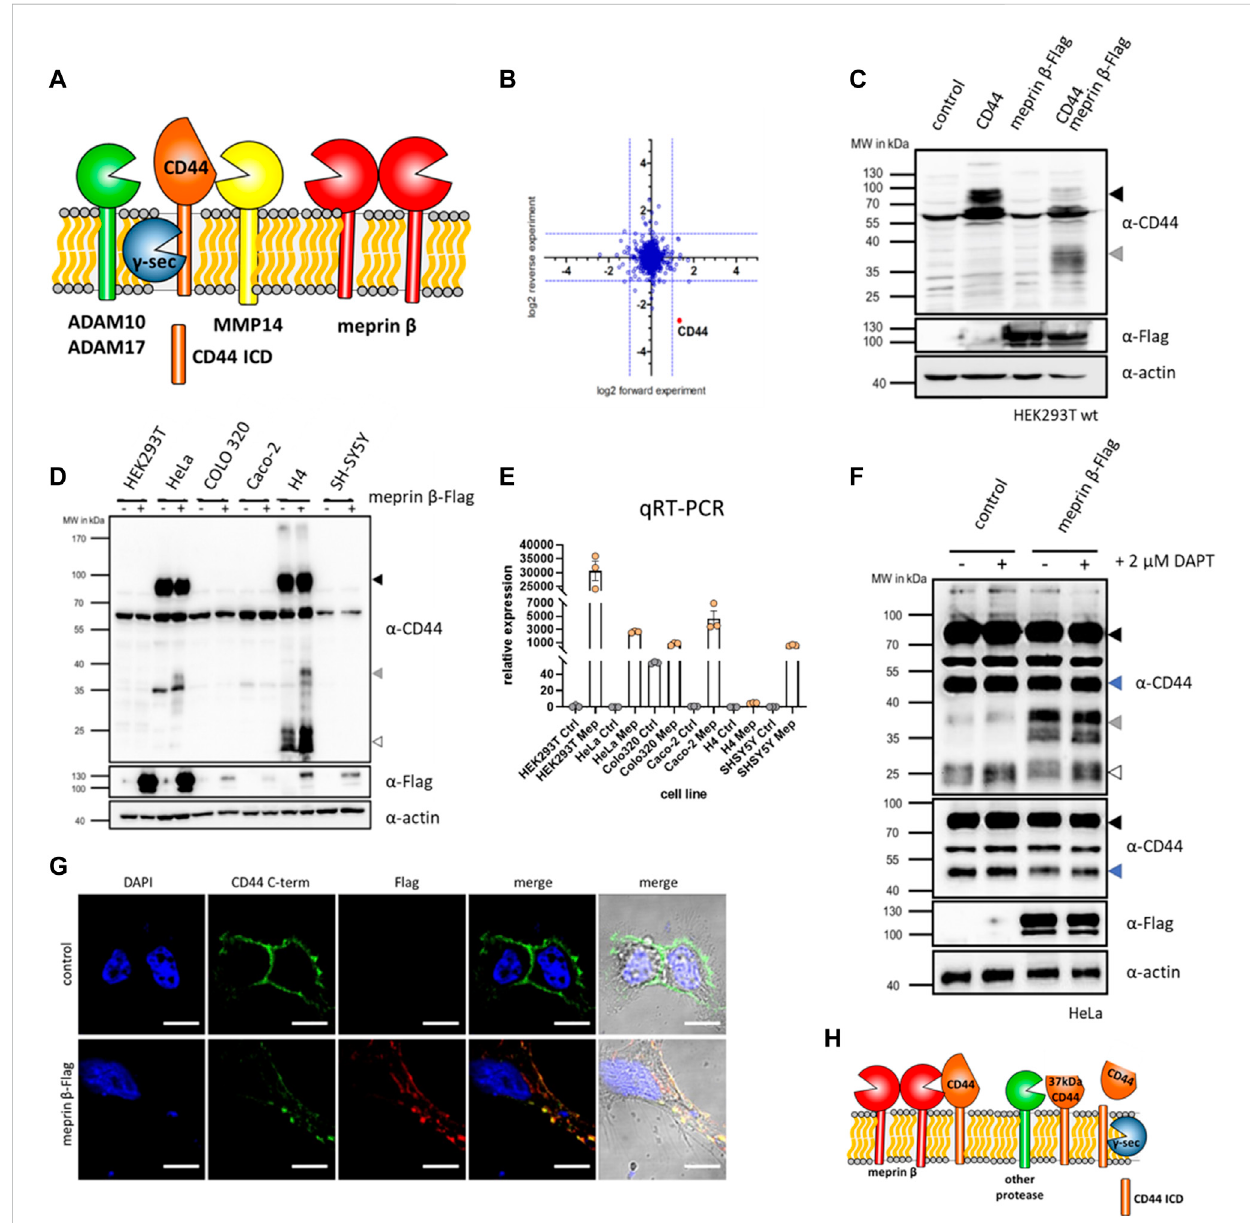
FIGURE 1 CD44cleavagebymeprin β . (A) CartoonofdifferentproteasescleavingCD44atthecellsurface. (B) Quantitativemassspectrometryshowsreduced levels of CD44 on fi broblasts stimulated with soluble meprin β . (C) Western blot of HEK93T cell lysates shows a 37 kDa truncated version of CD44 upon dual expression of CD44 and meprin β . (D) Western blot of different cell lines with or without transfection of meprin β blotted for endogenous CD44 (black arrow = full-length CD44, grey arrow = meprin β dependent cleavage fragment, white arrow = additional CTFs of CD44). (E) Expression of meprin β in different cell lines. (F) Control HeLa cells or transfected with meprin β and additionally treated with the γ -secretase inhibitor DAPT shows the accumulation of a 25 kDa CTF (white arrow) of CD44 and a meprin β dependent decrease in a 50 kDa (blue arrow) CD44 fragment. (G) Immuno fl uorescenceofcontrolHeLacellsormeprin β expressingonesstainedagainstendogenousCD44(green),meprin β (red)andthenucleus(blue). (H) Summarizingcartoonofmeprin β dependentCD44cleavagethatgeneratesa~37 kDalargetrimmedCD44atthecellsurface.Thisfragmentmightbe processed by a different protease to generate a 25 kDa γ -secretase dependent CTF. However, generation of the γ -secretase dependent CTF seems independent of meprin β